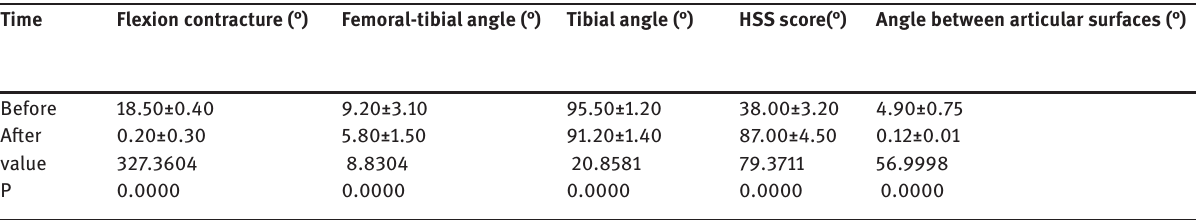
Table 1: Comparison of angles and HSS score between patients before and after surgery. Time Flexion contracture (°) Femoral-tibial angle (°) Tibial angle (°) HSS score(°) Angle between articular surfaces (°)